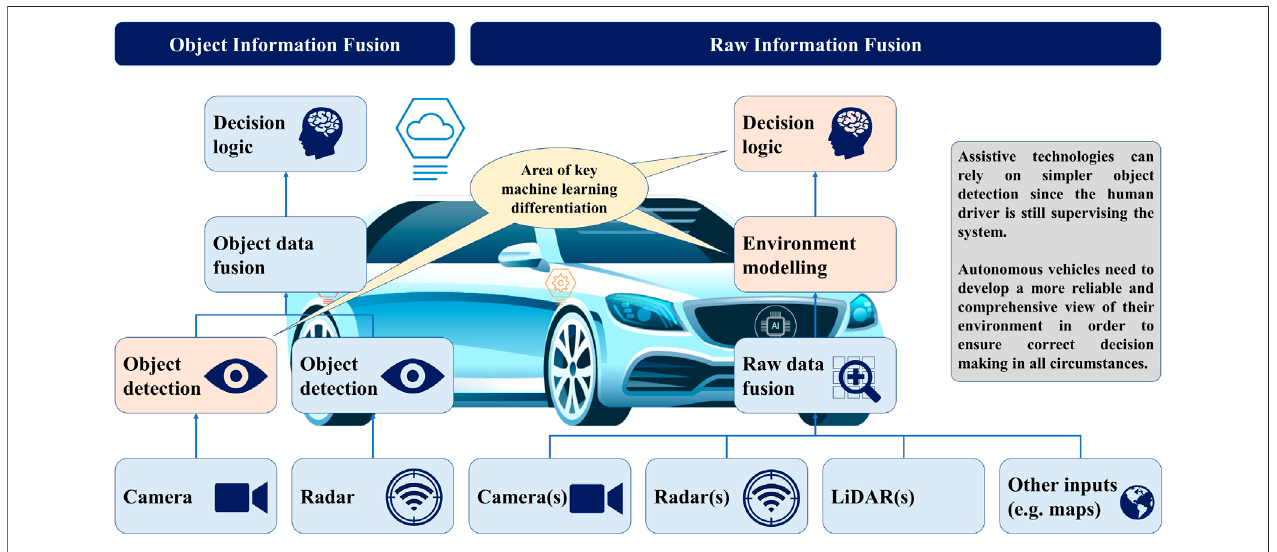
FIGURE 8 | Information fusion approaches in ECAS